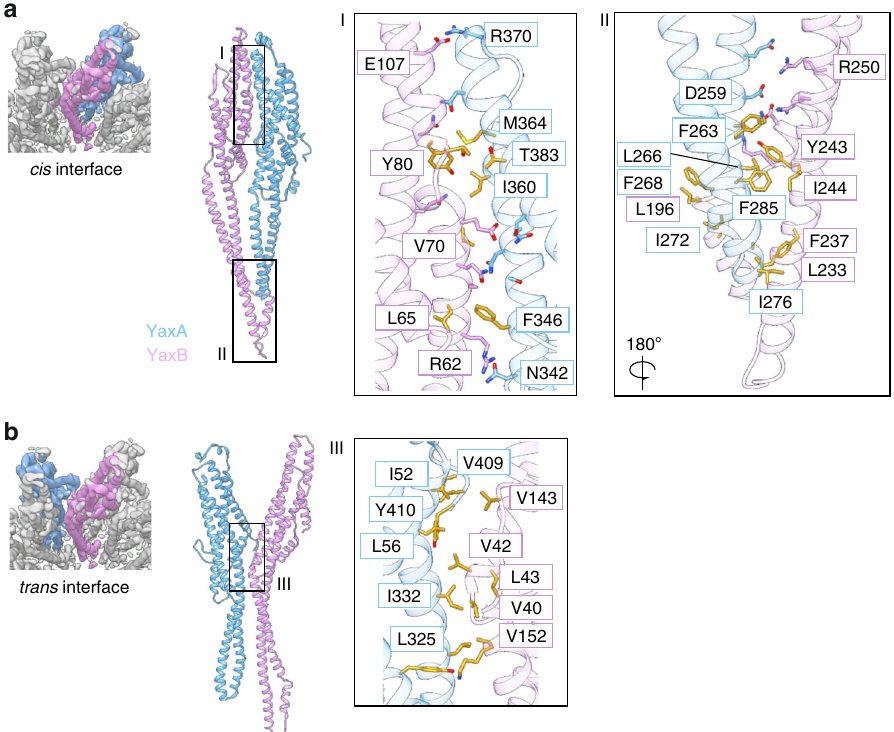
Fig. 3 YaxA and YaxB interact via cis and trans interfaces within the YaxAB complex. a Cryo-EM map (left) and modeled structure (right) of the cis interface between YaxA (blue) and YaxB (pink) within a radial spoke ( cis ). Boxes labeled I and II indicate contact regions within the protomer pair that are displayed enlarged (right). Residues in interacting proximity are shown as sticks; hydrophobic side chains are colored in gold. Given the medium resolution of the cryo-EM map, the side chains were modeled as ideal rotamers in phenix.real_space_re fi ne. b Depiction as in a , but of the trans interface between YaxA and YaxB from two adjacent radial spokes. Box III indicates the contact region within the protomer pair, colored as in